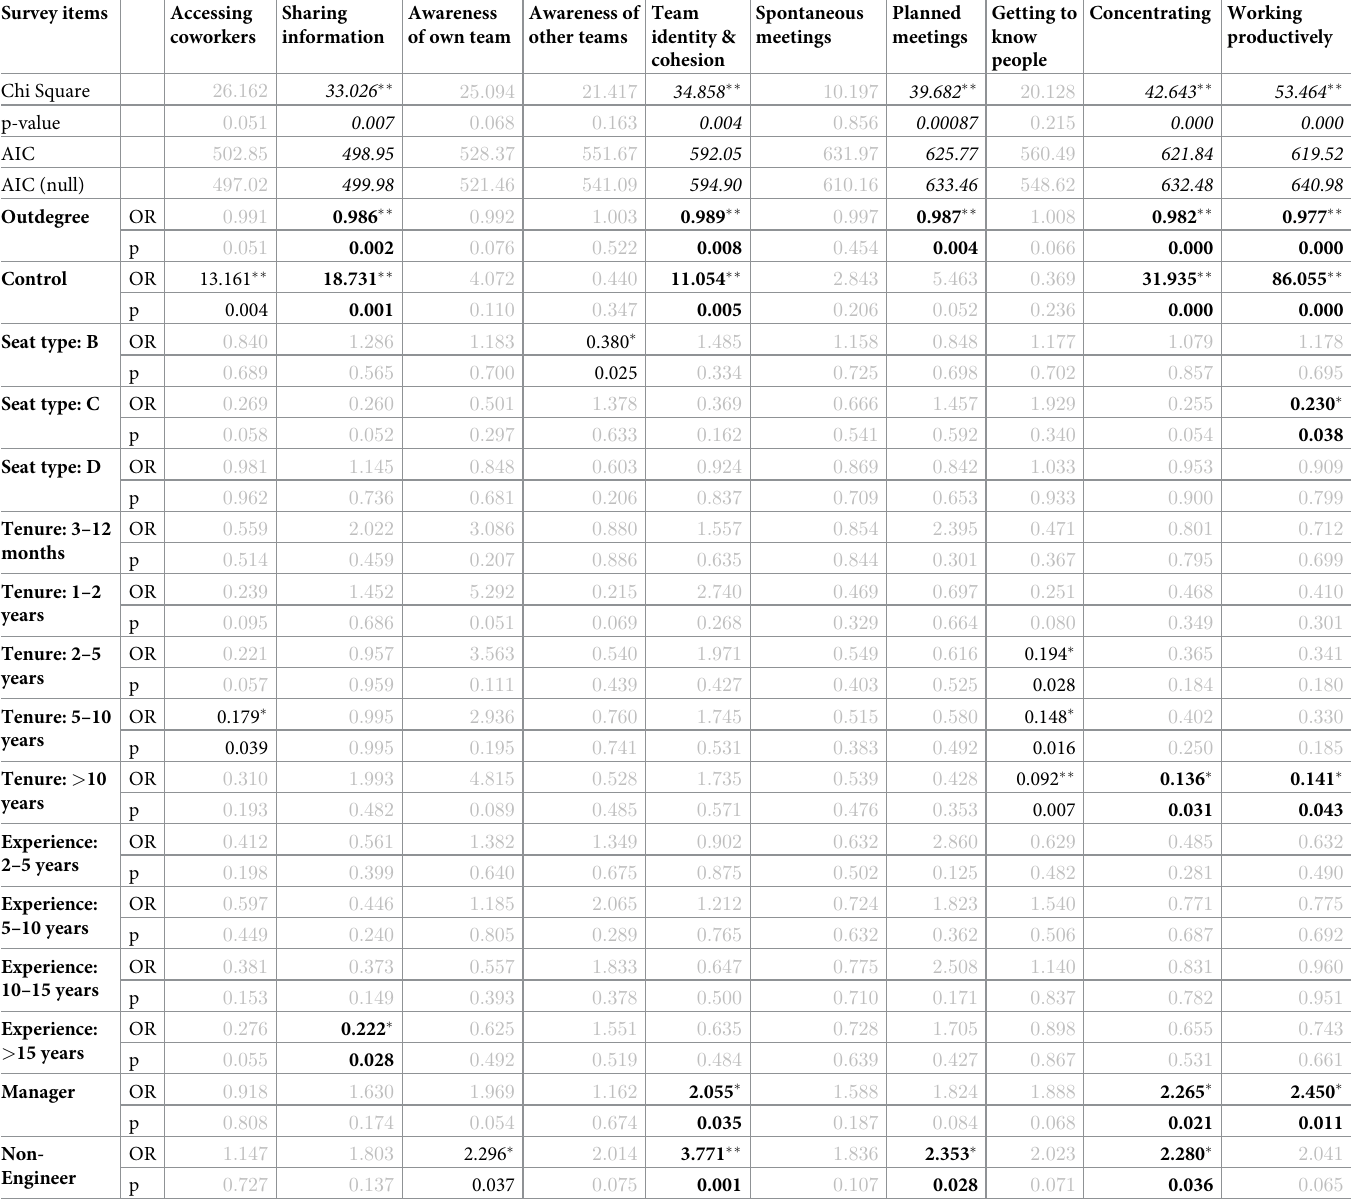
Table 2. Output from the multiple ordinal regression